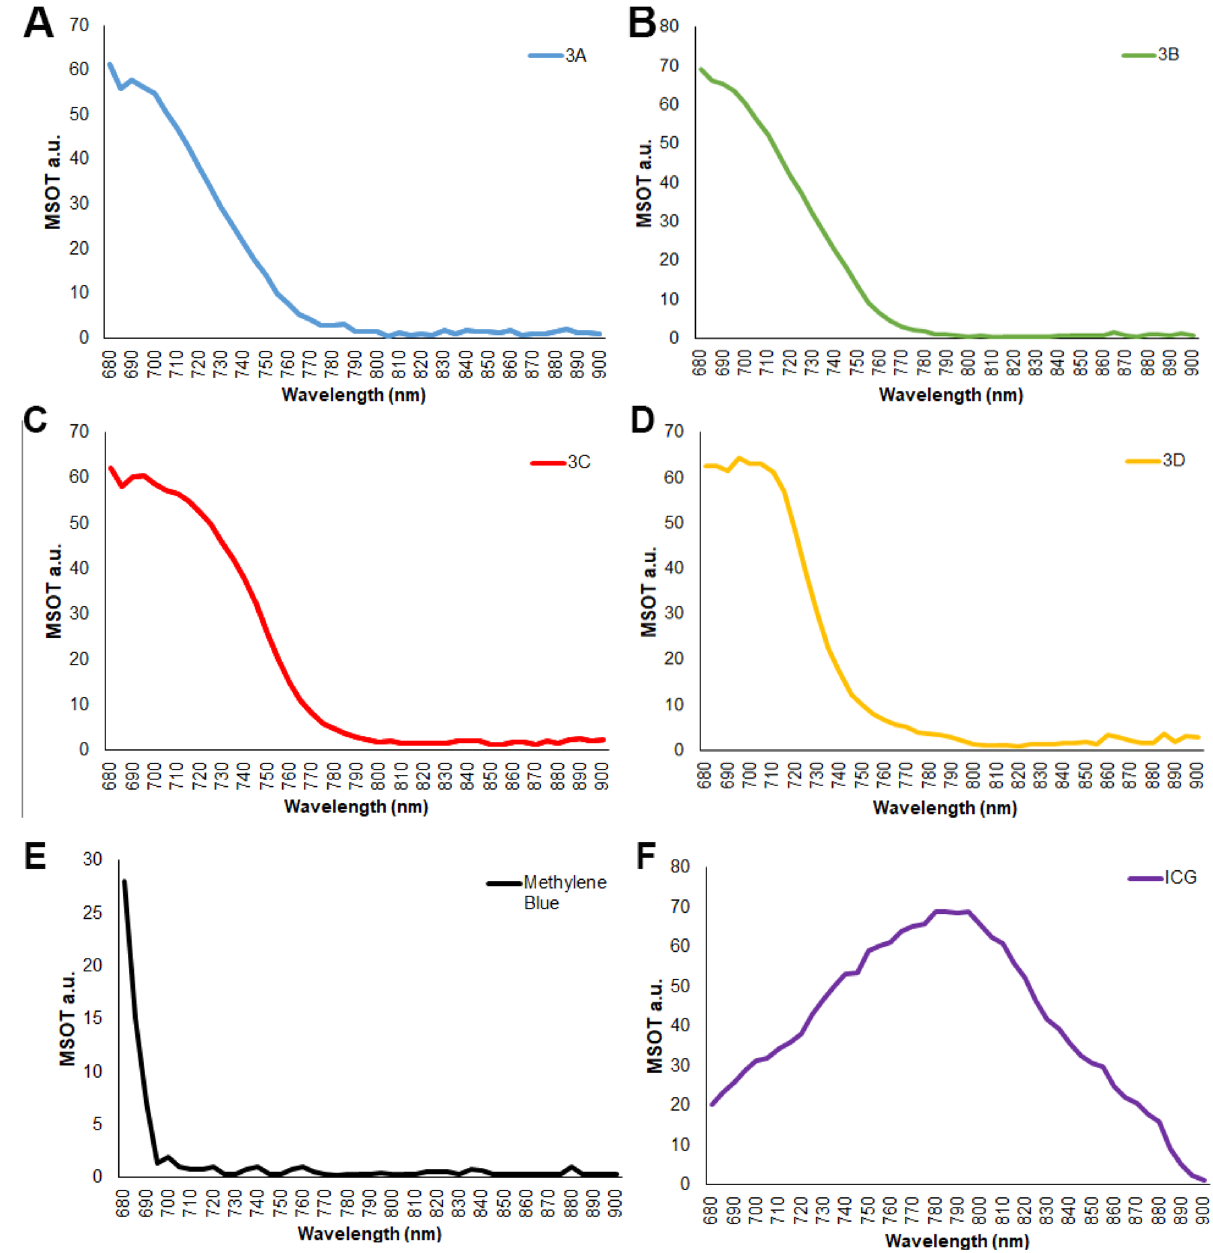
Figure 2. MSOT signal strength/dye concentration for the contrast agents 3A -D and commercial dyes. At 1 mg/mL, each dye was evaluated in the tissue phantom using the MSOT system. The phantoms were scanned at 680 nm through 900 nm at 5 nm wavelength intervals. The graphs shown are raw MSOT